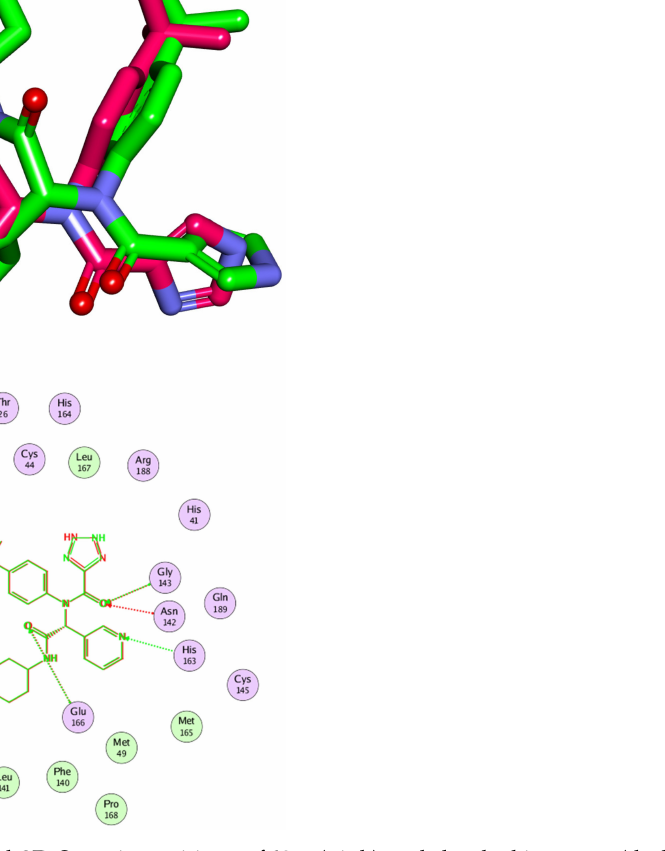
Figure 9. 3D and 2D Superimpositions of X77 (pink) and the docking pose (dark green) of the same